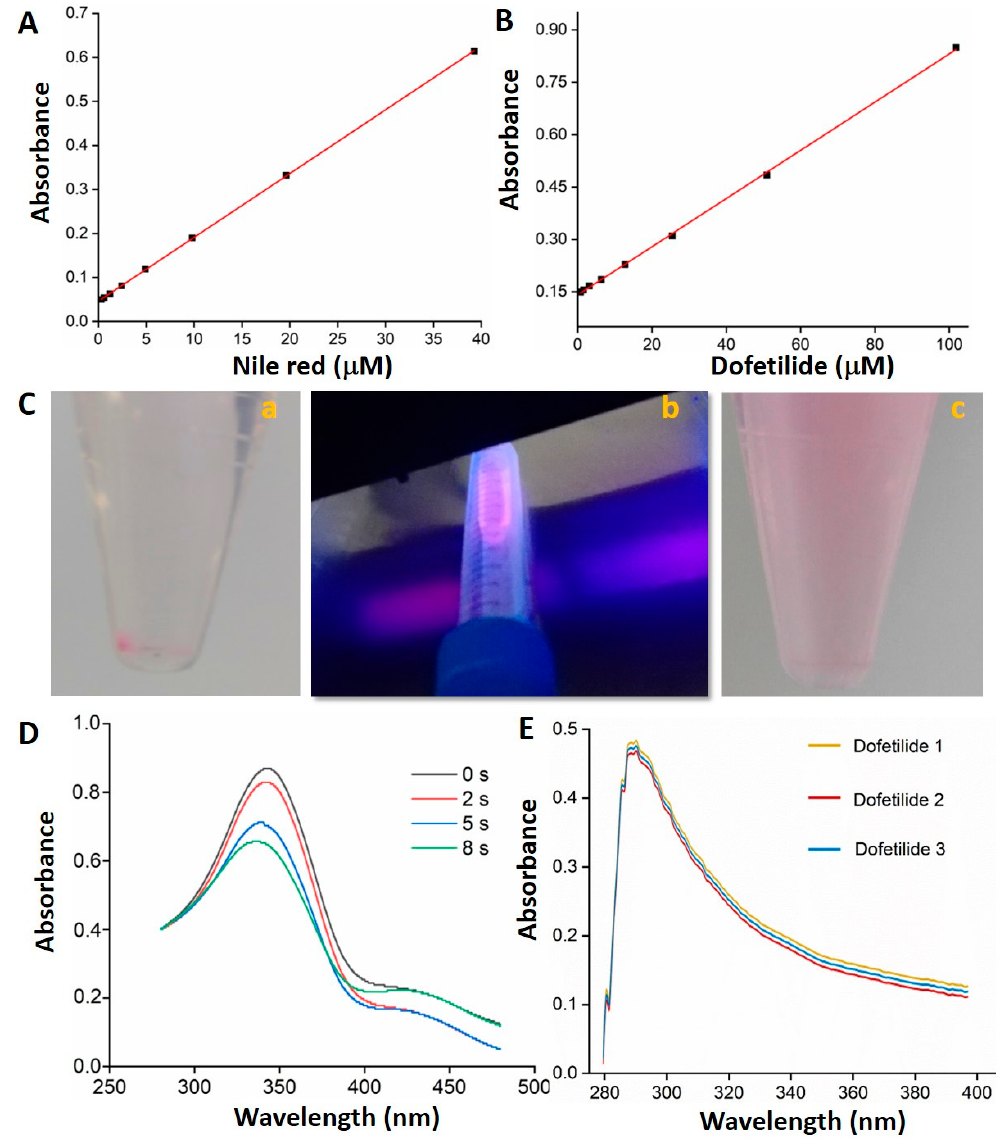
Figure 7. Calibration curves of Nile red ( A ) and dofetilide ( B ) in DMSO. Nile red photorelease process ( C ). Pictures of Nile red encapsulated by PPNPs centrifuged ( a ), UV irradiated ( b ), and photodelivered ( c ). UV-vis spectra variation of azobenzene-based polymeric nanocarriers by trans–cis photoisomerization at different UV irradiation times ( D ). UV spectra of photodelivered dofetilide ( E ).